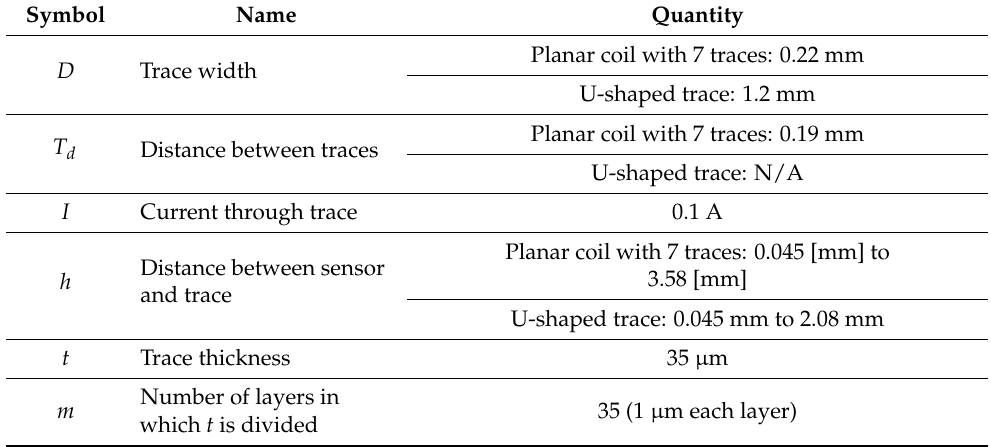
Table 1. Parameters utilized for the analytical model and COMSOL simulation (U-shaped trace and planar coil).